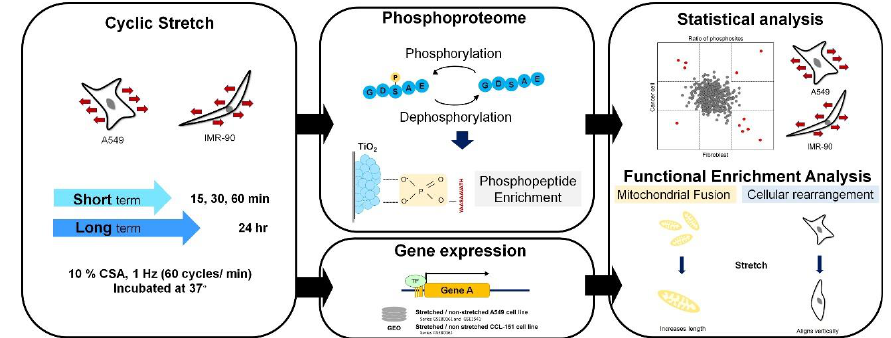
Figure 1. Experimental procedure and workflow of cyclic stretching-induced phosphoproteomics analysis. In this study, we applied short-term (15, 30, and 60 min) and long-term (24 h) stretching to two cell lines. Collected proteins were digested and processed, then enriched for phosphopeptides using TiO 2 . Phosphopeptides were analyzed by mass spectrometry. Phosphoproteome data were quantified and identified using MaxQuant software. We performed the functional enrichment of stretching-induced genomic and phosphoproteomic differential expressed genes/proteins.